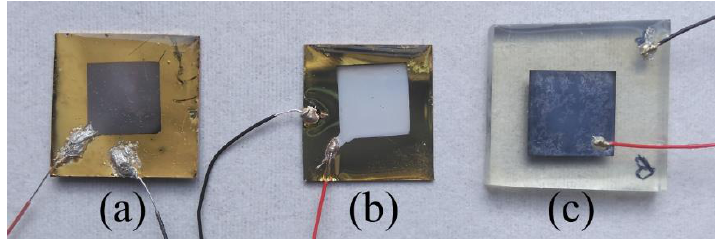
Figure 3. Images of PENGs made from ZnO NWs grown on ( a ) Au; ( b ) ZnO and ( c ) AZO seed layers.